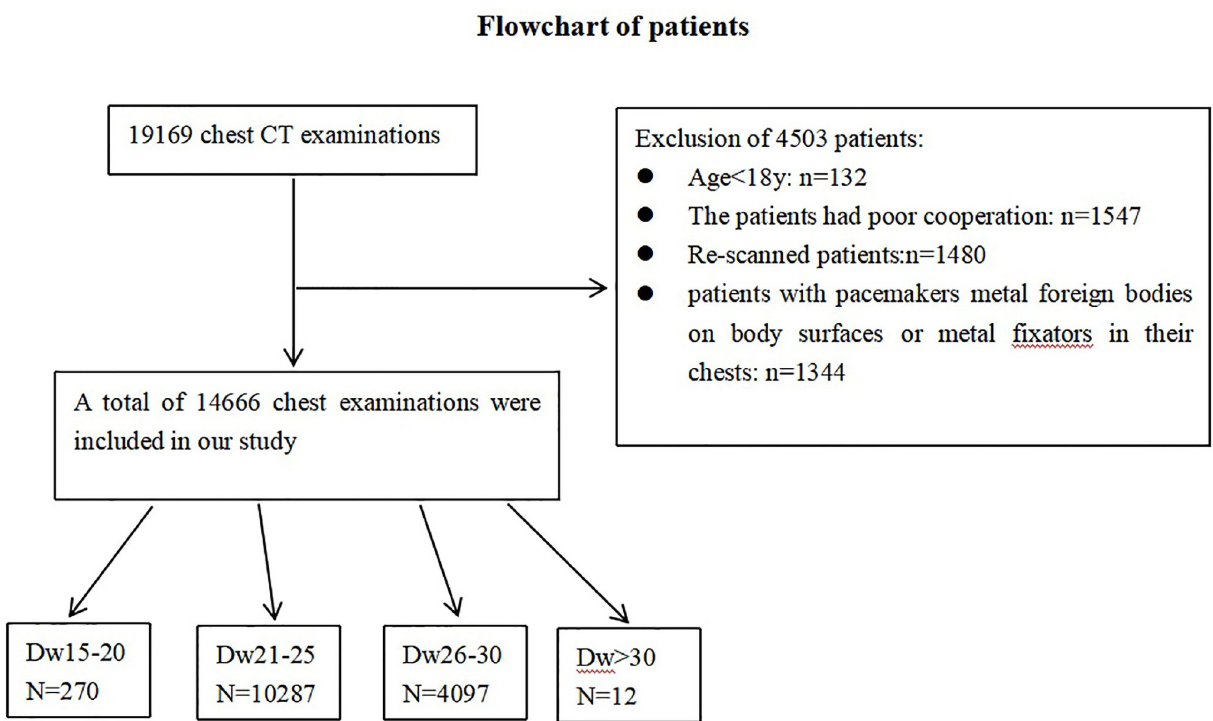
Fig 1. Number of CT examination enrolled in this study and divided into subgroups on the basis of water-equivalent diameter(Dw), with exclusion criteria.